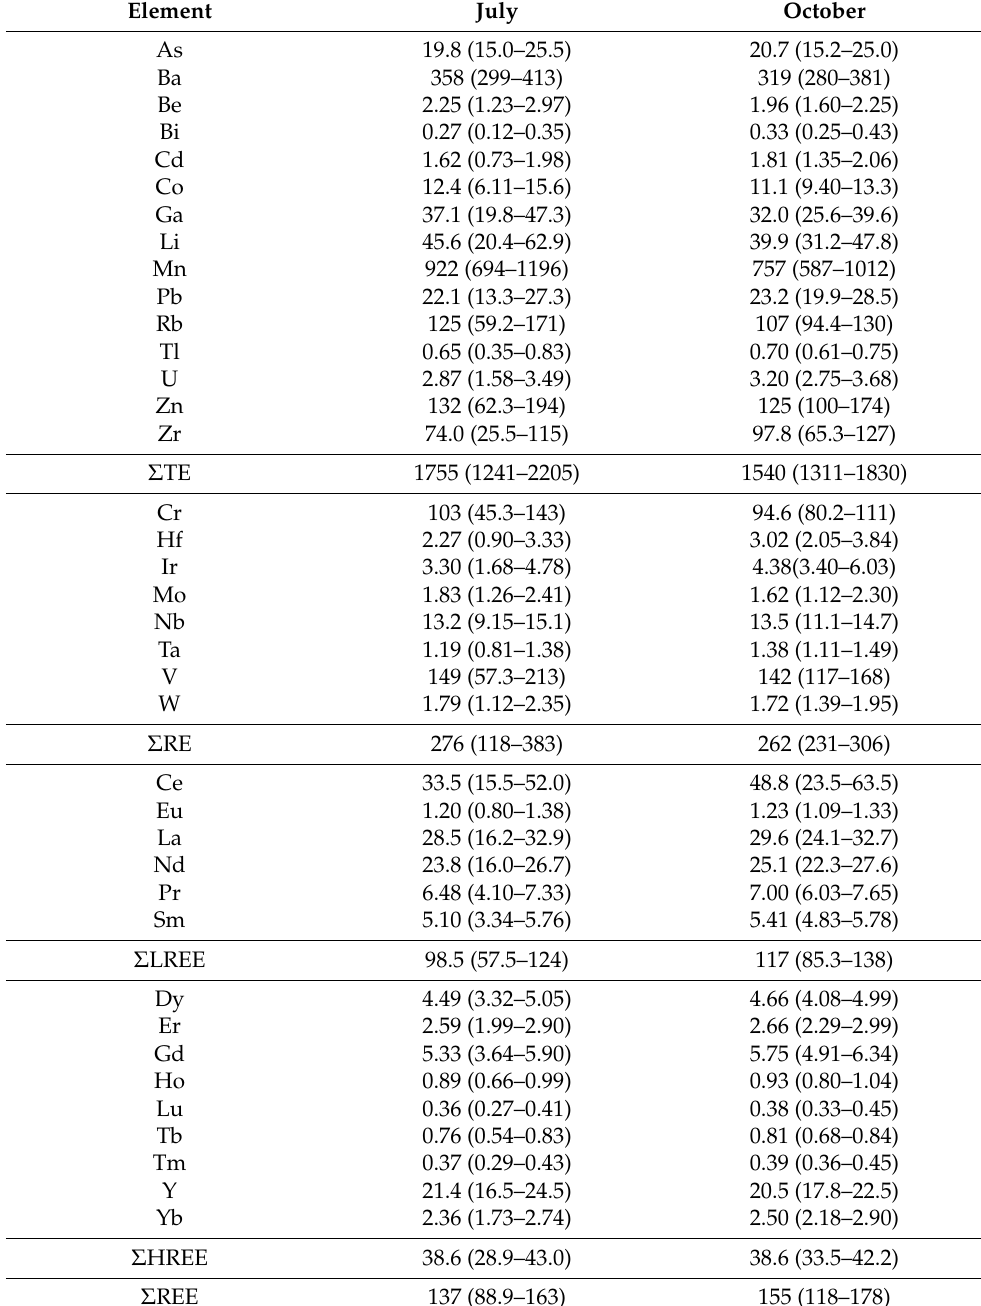
Table 2. Descriptive statistics for the TE, RE, and REE concentrations in sediment ( µ g g − 1 , n = 14/session) samples collected in July and October 2017 from Podu Iloaiei Dam Lake, Roma- nia. Data are presented as mean